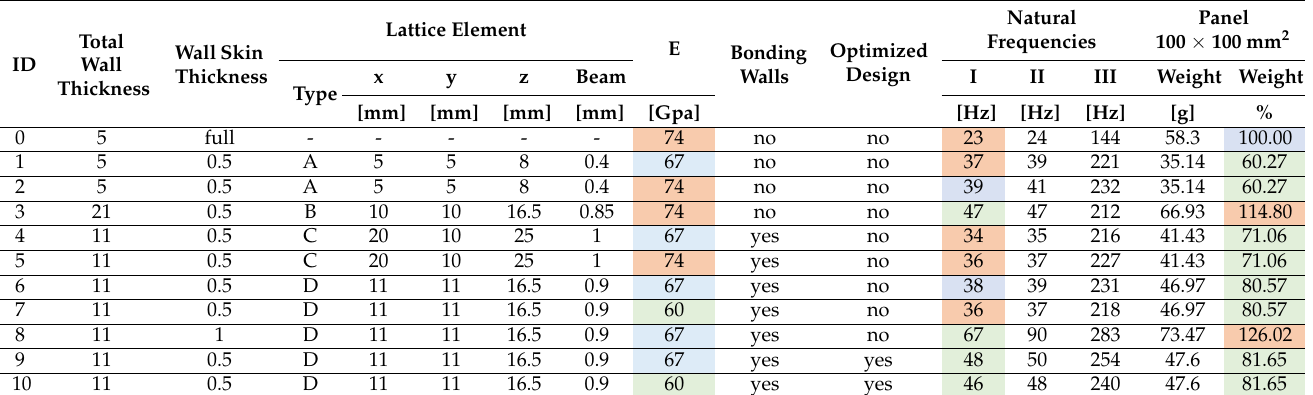
Table 6. Modal analyses and weights for investigated lattice